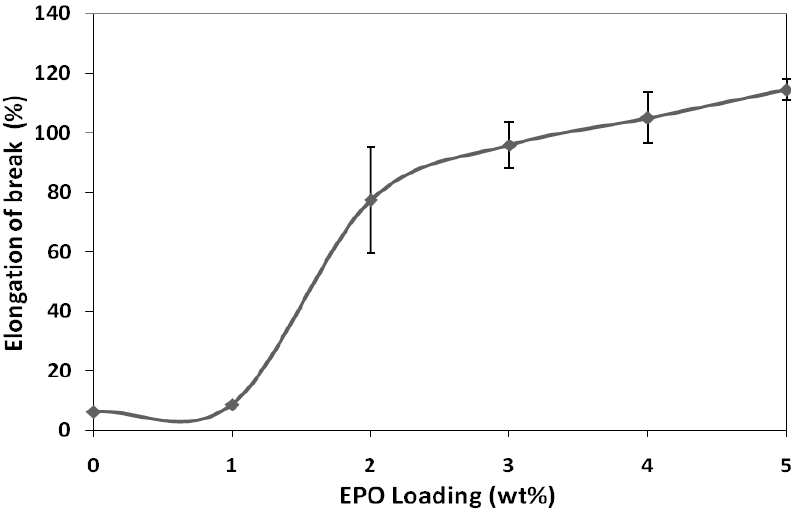
Figure 2. Elongation-at-break of neat PLA and PLA/EPO